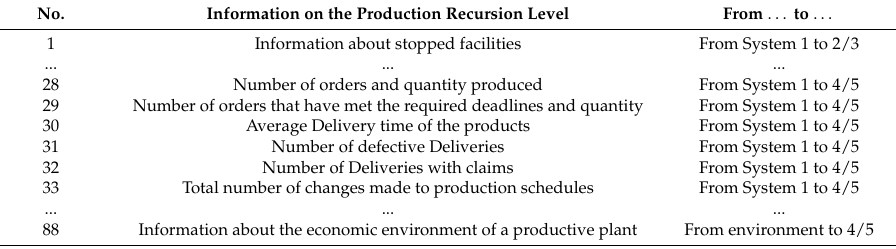
Table 3. Extract of information flows in the production recursion level (own